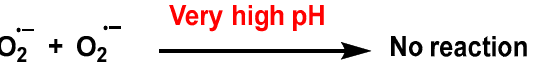
Figure 27. At very high pH, the superoxide anion does not disproportionate.